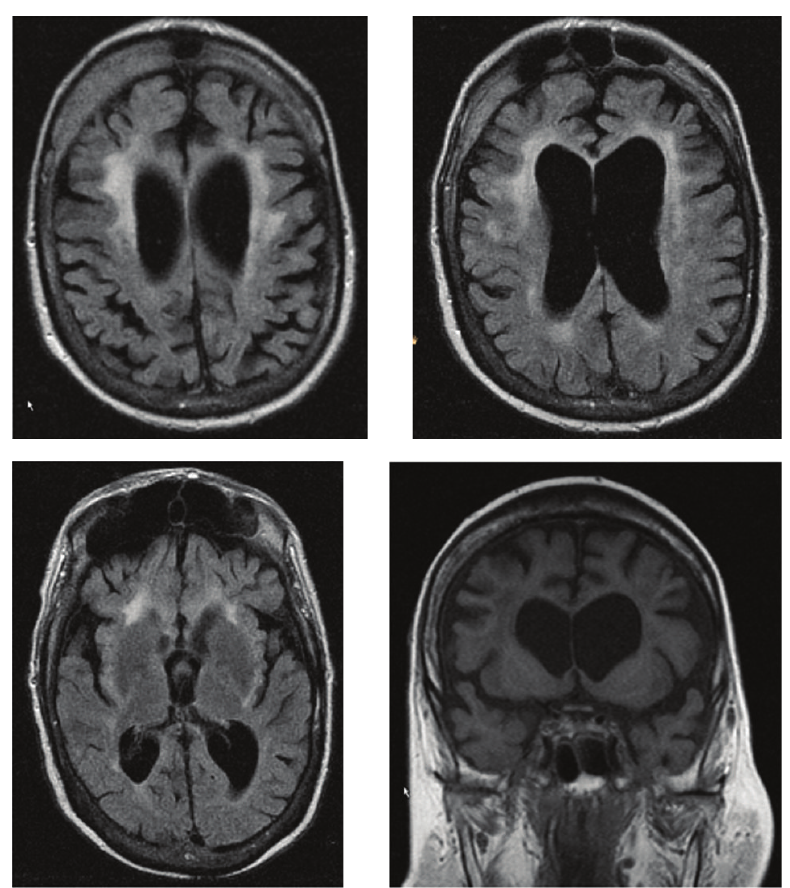
Figure 1: MRI of the cerebrum showing diffuse atrophy gliotic spots and leucoaraiosis. Pneumosinus dilatans can be also